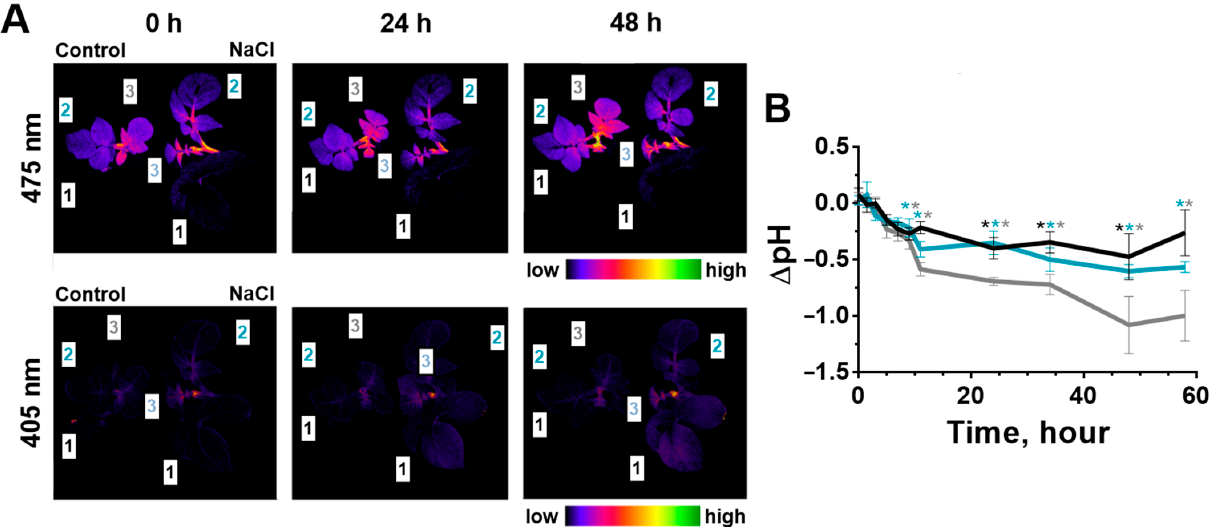
Figure 6. Change in fluorescence of the Pt-GFP sensor and cytosolic pH in different stratum of potato leaves (1, 2, 3) during salinity. ( A ) Changes in transgenic plant fluorescence (excitation of 475 and 405 nm) are demonstrated as whole-plant imaging in the pseudo-color scale in control (Control) and salt-treated (NaCl) plants at three time points (0, 24 and 48 h) of salt stress. Cytosolic pH ( B ) increased relative to control (water-treated plants) values (leaves: 1—black, 2—blue, 3—gray). The data are presented as mean ± SEM (n = 9), * p < 0.05 control versus salt treatment.